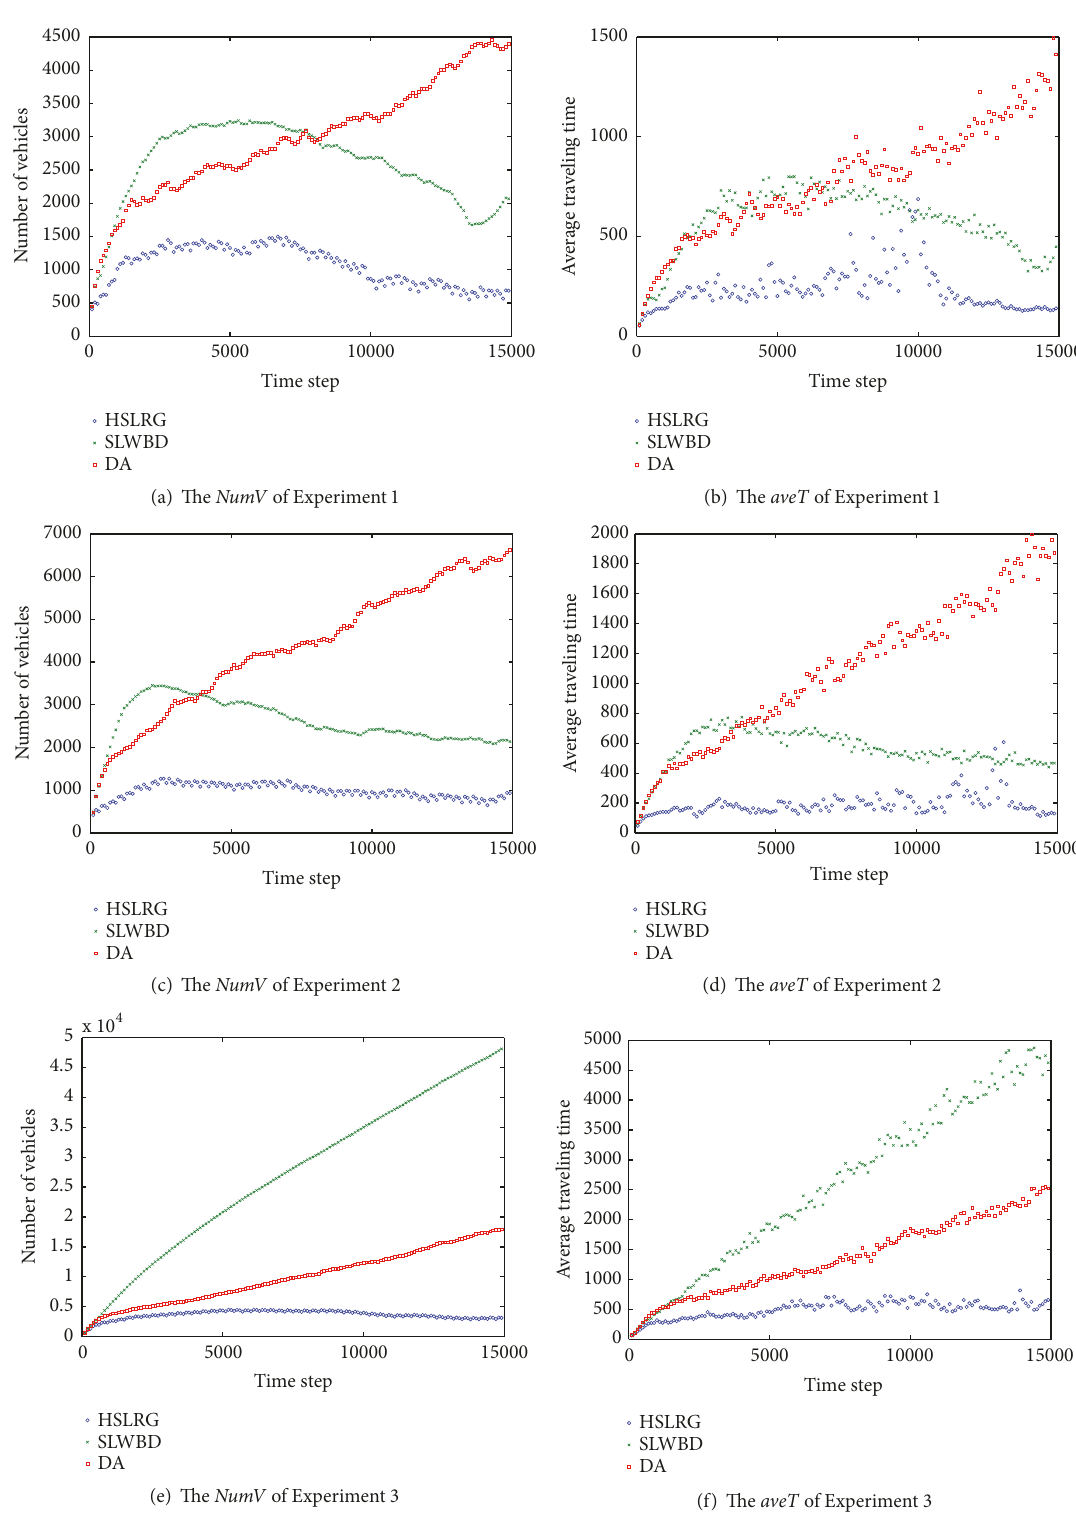
Figure 6: The results of